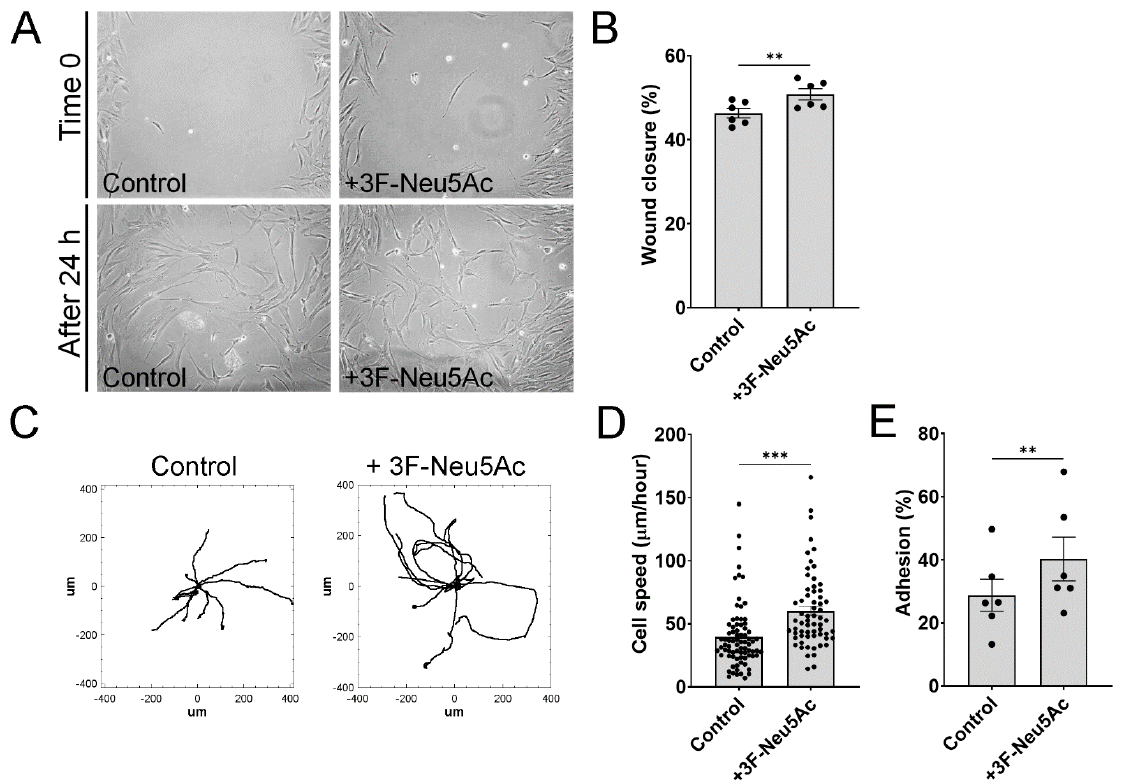
Figure 3. 3F-Neu5Ac pre-treatment promotes migration of MSCs in vitro. ( A ) Representative images of wound/scratch assays, immediately after insert removal and 24 h after starting the assay. ( B ) Quantification of wound closure, indicative of higher cell migration (n = 6). ( C ) Representative trajectories of individual cells using videomicroscopy. ( D ) Quantification of cell speed (n = 3). ( E ) MSCs pre-treated with or without 3F-Neu5Ac were lifted to be in suspension and then allowed to attach for 10 min to uncoated culture plates (n = 6). ** p < 0.005; *** p < 0.0005.